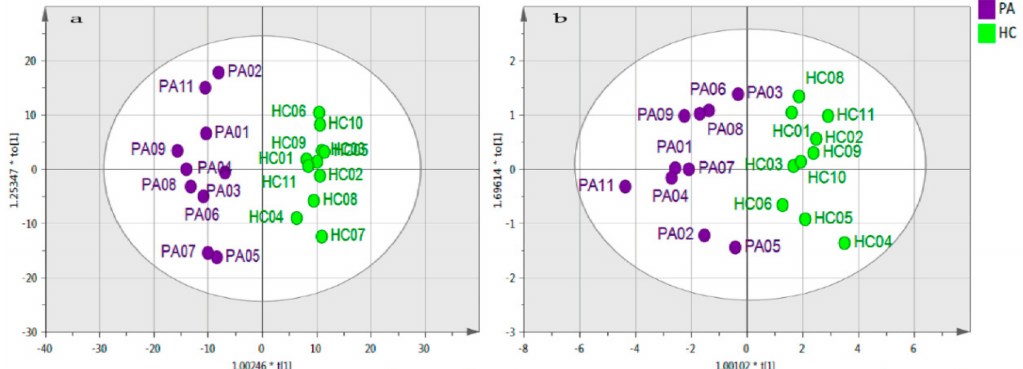
Figure 2. OPLS-DA score plot of pre-EEN samples (PA) against healthy controls (HC). ( a ) The OPLS-DA model based on 376 metabolites. The model consists of one predictive x -score component, component t[1], and one orthogonal x -score component to[1]. The t[1] component explains 19.1% of the predictive variation in x , while the to[1] component explains 11.6% of the orthogonal variation in x , R2X (cum) = 0.307. The goodness of fit (R2) = 0.96, the goodness of prediction (Q2) = 0.848 and the p value associated with the cross-validation analysis of variance (CV-ANOVA) = 5.41 × 10 − 6 . The PA10 sample was excluded as outlier. ( b ) The OPLS-DA model based on 8 differentiated metabolites. The model consists of one predictive x -score component, component t[1], and one orthogonal x -score component, to[1]. The t[1] component explains 677% of the predictive variation in x , while the to[1] component explains 11.7% of the orthogonal variation in x , R2X (cum) = 0307. R2 = 0.837, Q2 = 0.57, and p CV-ANOVA = 1.47 × 10 − 2 . The PA10 and HC07 samples were excluded as outliers. Both models were based on log base 2 variables that were Pareto